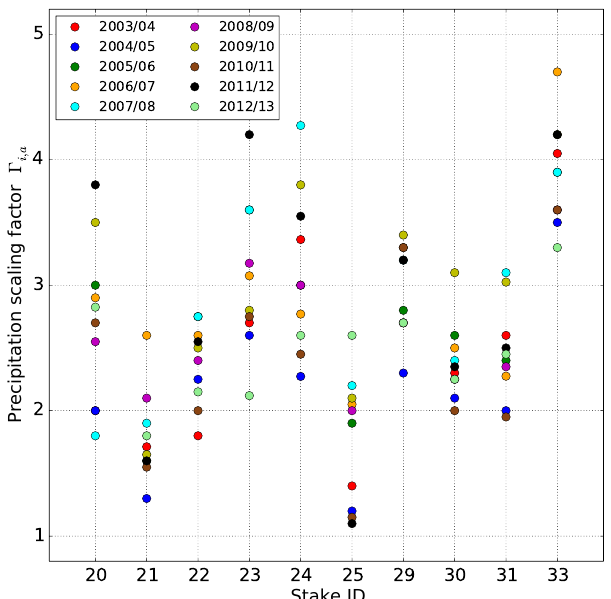
Figure 5. Precipitation scaling factors (cid:48) for different locations ( i ) and years ( a